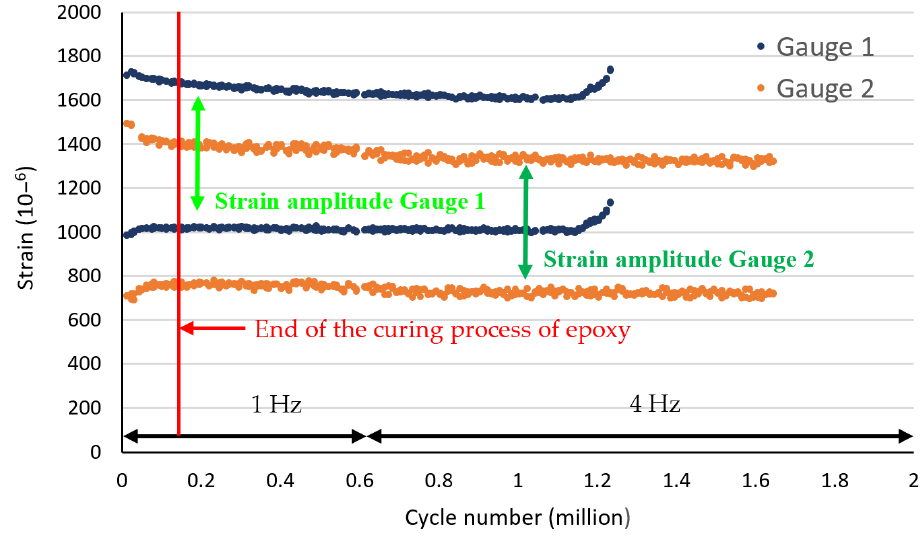
Figure 12. Strain extremes in the two steel rebars (at mid-span) during fatigue test for beam ES2.